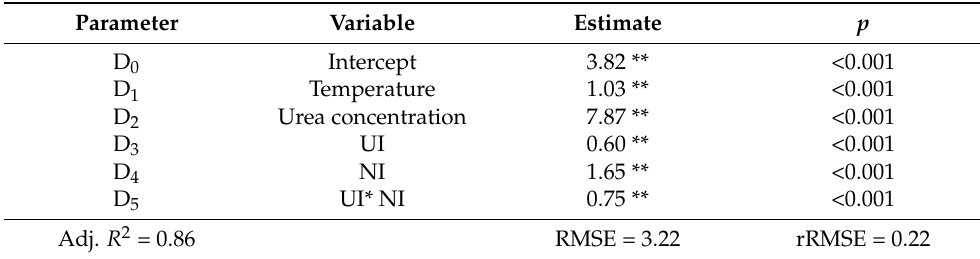
Table 4. Parameter estimates by multiplicative regression (Equation (6)).